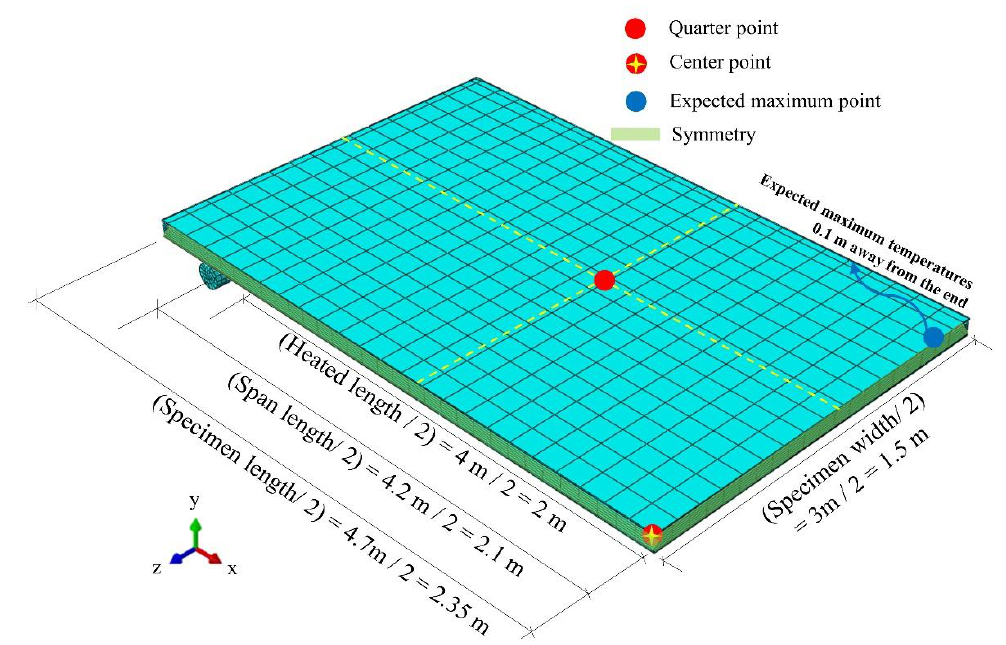
Figure 8. Configuration of full-scale fire tests.